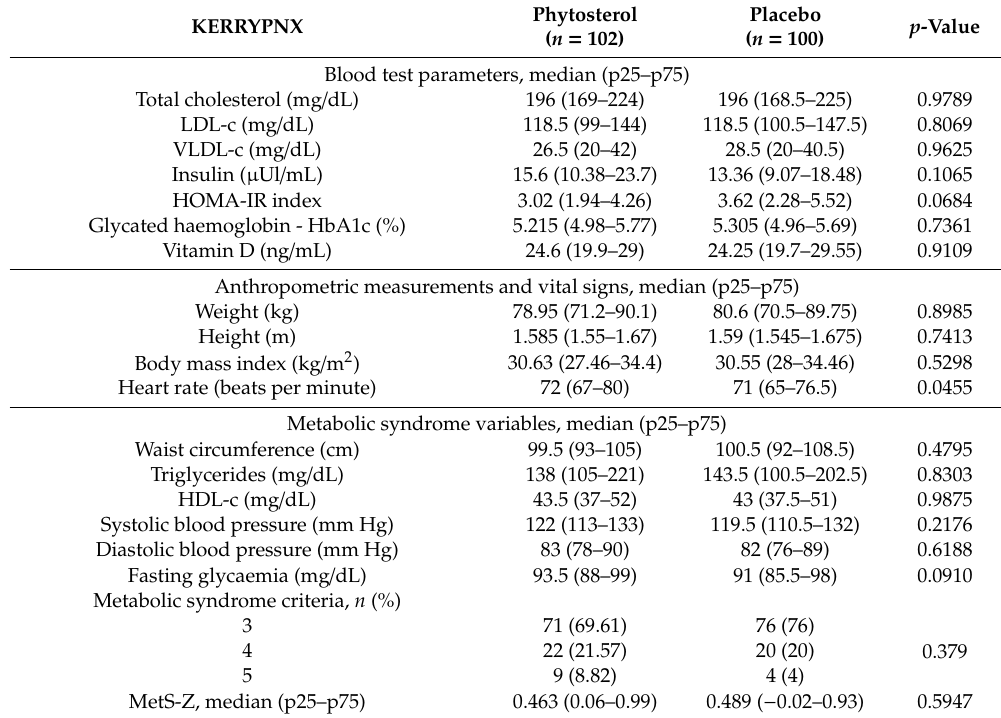
Table 3. Distribution of MS criteria met by participants at V4 and the di ff erence between V4 and V1.